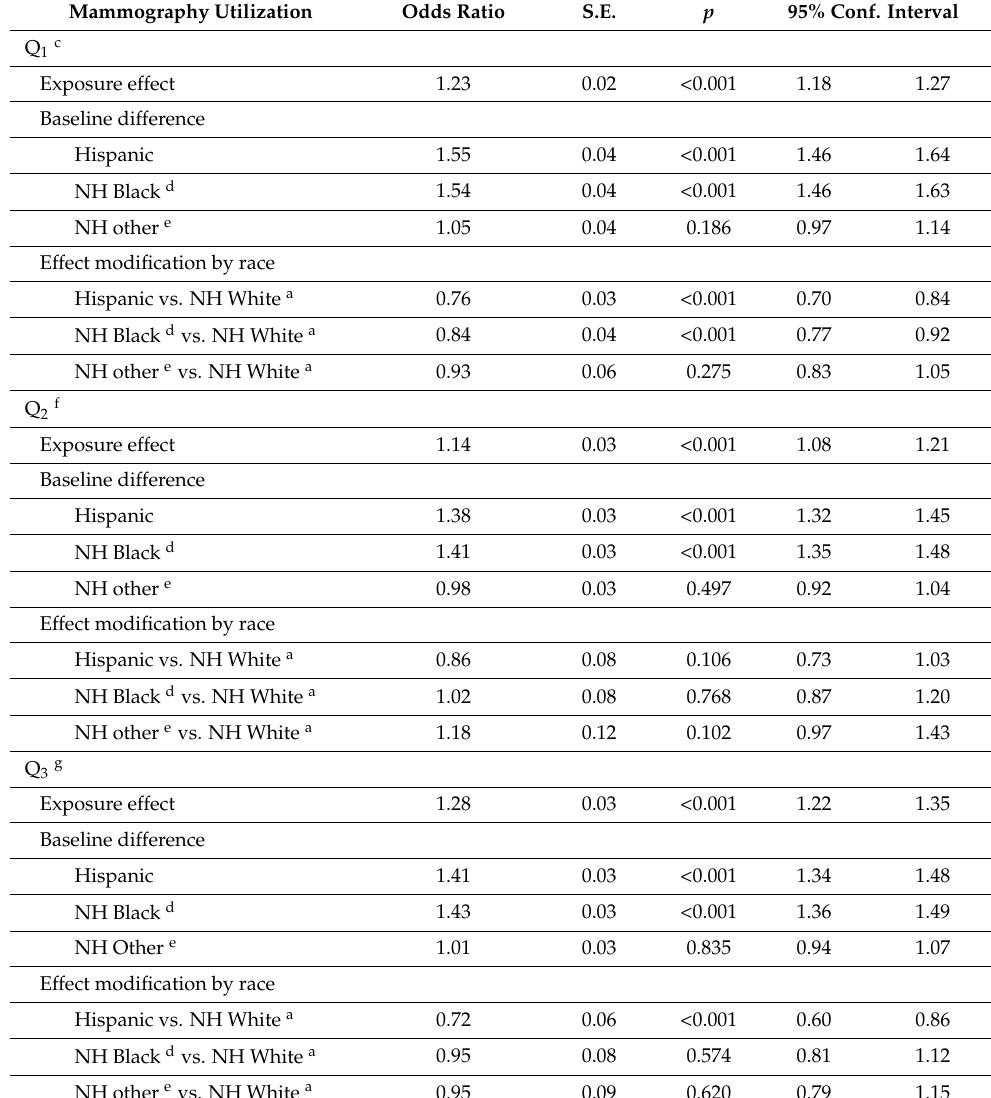
Mammography Utilization Odds Ratio S.E. p 95% Conf.